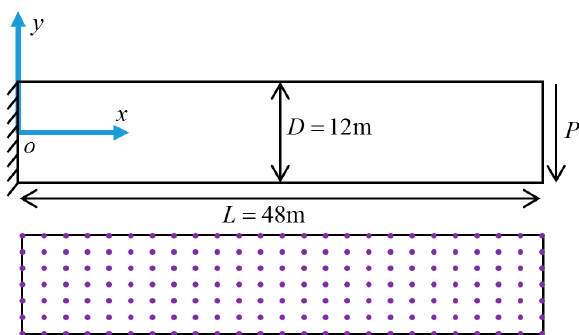
Figure 6. Model of cantilever beam and distribution of field nodes.